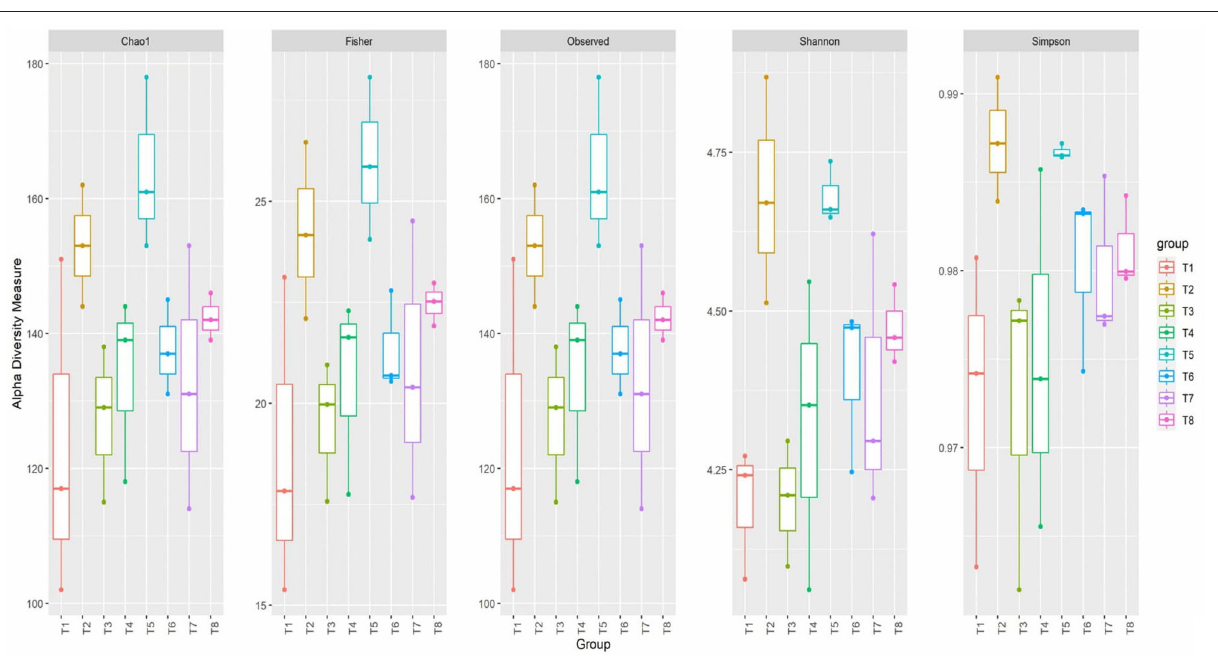
Frontiers in Veterinary Science |